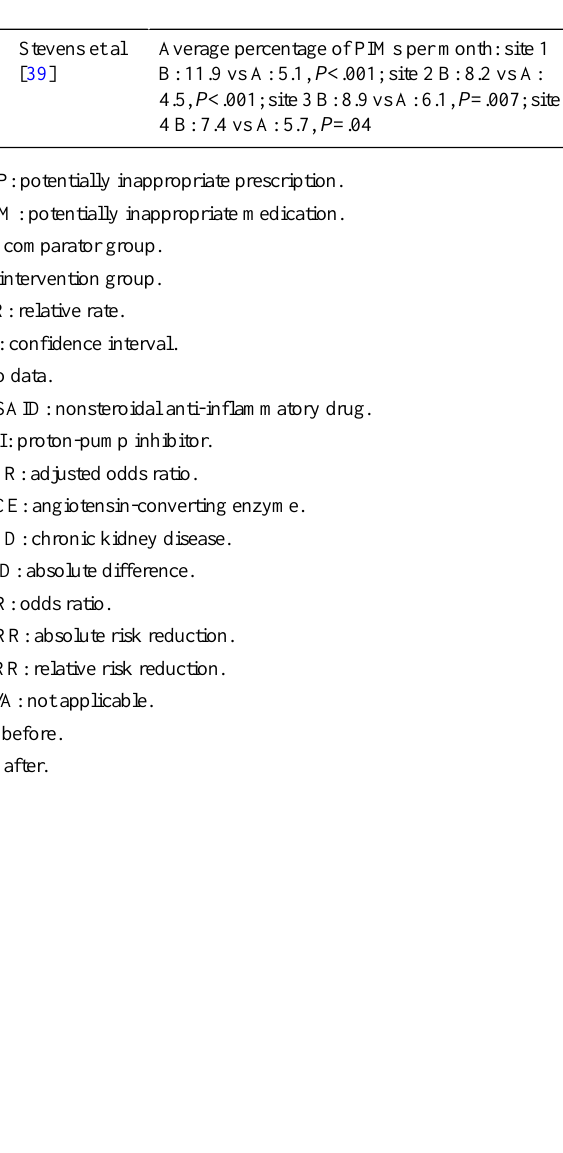
Changes in specific PIP or PIM drugsChanges in PIP or PIM